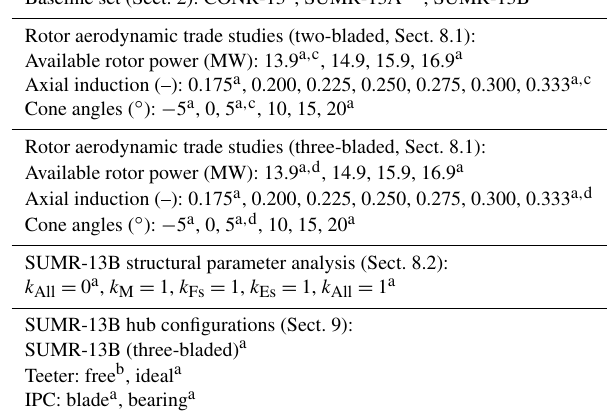
Table 3. Set of turbines designed and analyzed in this article. a de- notes a turbine for which DLC simulations were performed and used to map the harmonic load estimates to DLC-based design loads. Otherwise, only the harmonic load analysis is performed. b was omitted from the transformation set. c denotes the SUMR- 13A rotor and d denotes a three-bladed variation of the SUMR-13A rotor. The process for using axial induction as an independent de- sign variable will be described in the rotor aerodynamic trade stud- ies section (Sect.